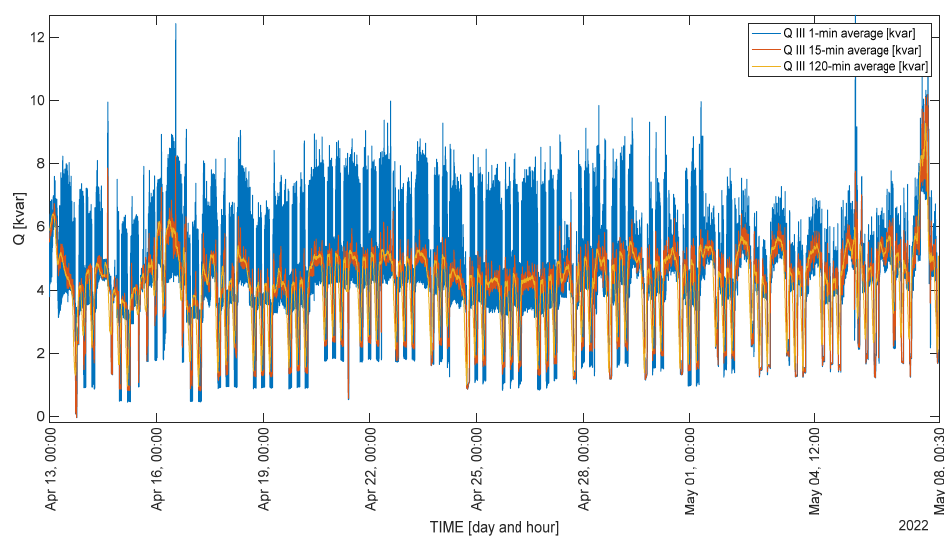
Figure 6. Three-phase reactive power as a function of time in the 2nd stage of the cycle.